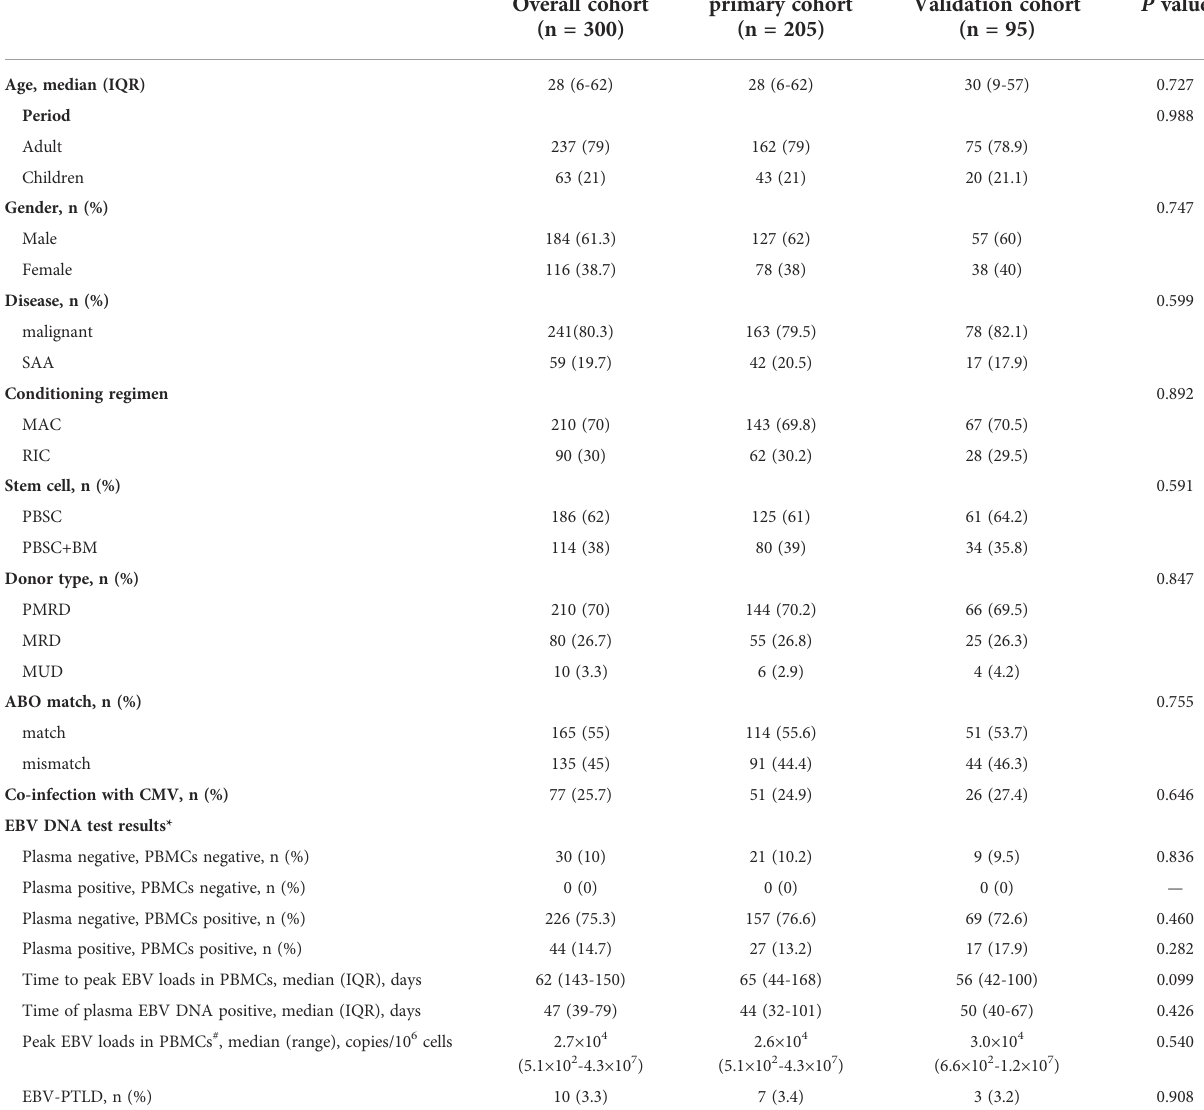
TABLE 1 Clinical characteristics and EBV DNA results in the primary and validation